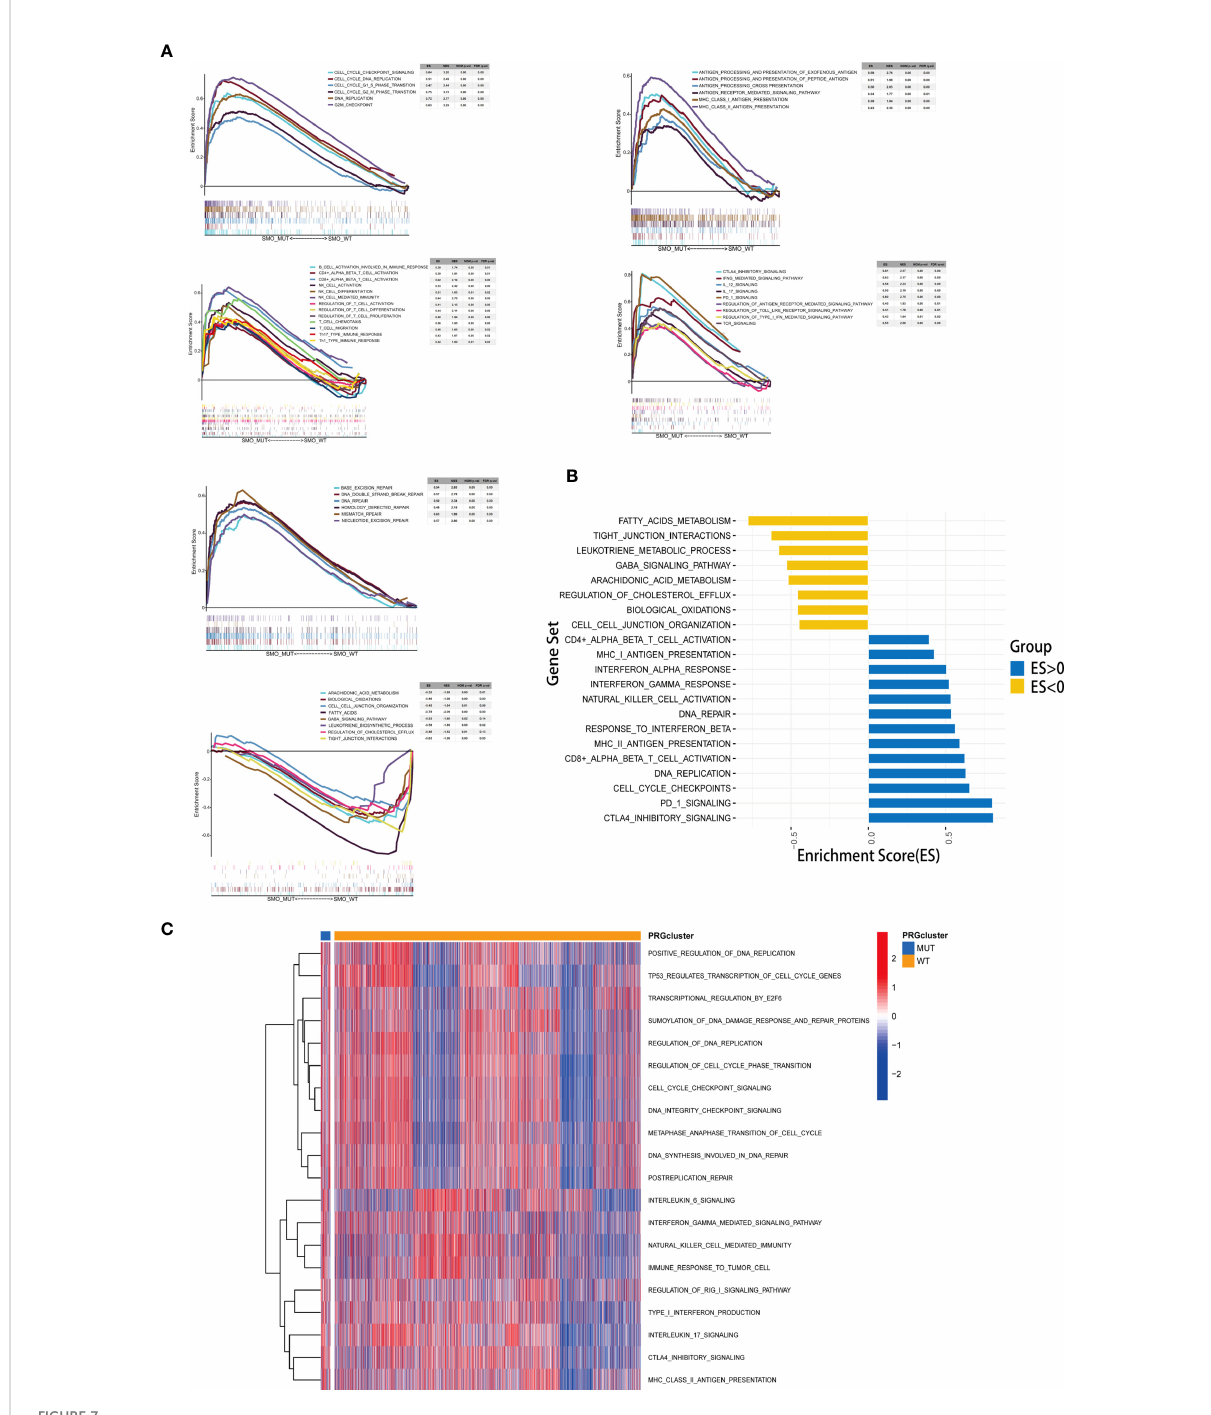
FIGURE 7 Correlation between the SMO mutation status and signaling pathways. (A) Gene set enrichment analysis (GSEA) of Gene Ontology biological process (GO-BP), Hallmark, and Reactome gene sets downloaded from MSigDB. In each panel, the gene sets marked on the left were enriched in the SMO mutant (SMO_MUT) group, while the pathways marked on the right were enriched in the SMO wild-type (SMO_WT) group. Each run was performed with 1,000 permutations. (B, C) Differences in pathway activities scored using GSEA (B) and gene set variation analysis (GSVA) (C) between the SMO_MUT and SMO_WT tumors in The Cancer Genome Atlas (TCGA) cohort. Enrichment results with signi fi cant associations between the SMO_MUT and SMO_WT tumors are shown. In (B) , the blue bar indicates that the enrichment score (ES) of the pathway is more than 0, while the yellow bar indicates that the ES of the pathway is less than